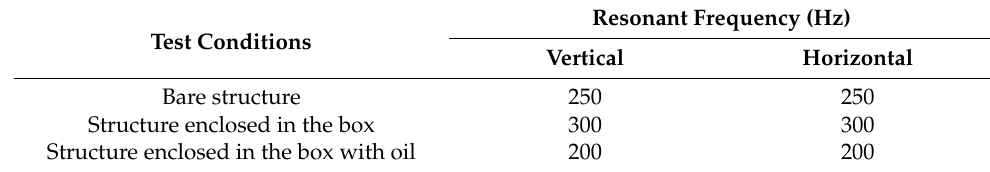
Resonant Frequency (Hz) Vertical Horizontal